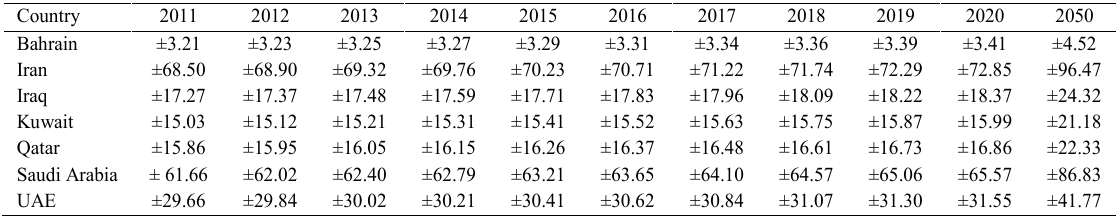
Table 4: Confidence interval of projected data from 2011 to 2050